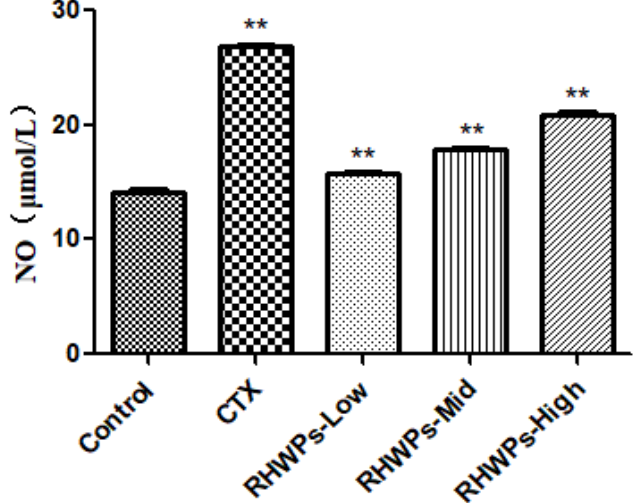
Figure 10. Effect of RHWPs on NO content in serum of S180 tumor-bearing mice. The concentration of NO in serum of S180 tumor-bearing mice was determined by ELISA kit. Data are means ± SD ( n = 10). Significant differences from the control groups are designated as ** p < 0.01.